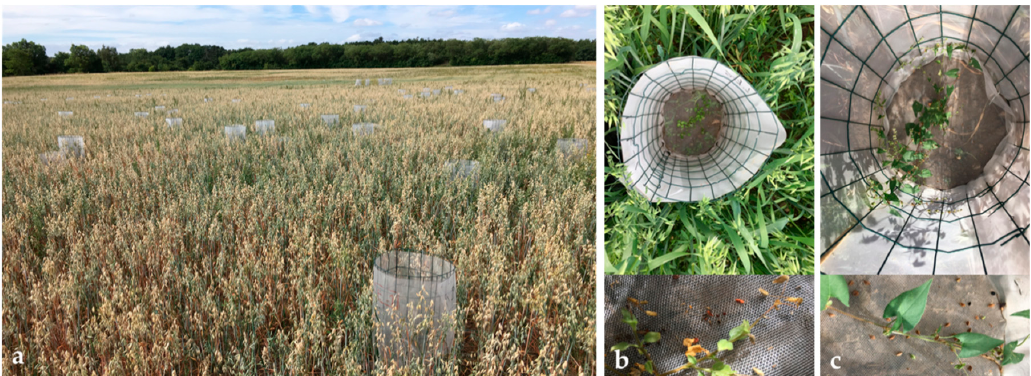
Figure 1. ( a ) Seed traps in the oat field in 2018. Maturing plants and shattered seeds of ( b ) Stellaria media and ( c ) Fallopia convolvulus in traps in 2019.